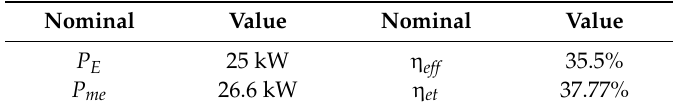
Table 2. Input and output power and efficiency demands.